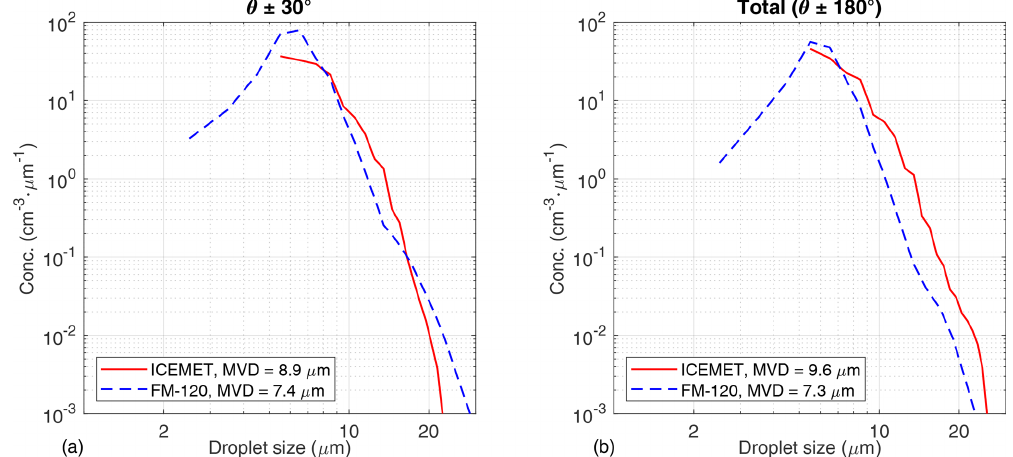
Figure 7. Intercomparison between ICEMET (red line) and FM-120 (dashed blue line) median DSDs for (a) isoaxial sampling with angular deviation ( θ ± 30 ◦ ) and (b) the total data set including all wind directions ( θ ± 180 ◦ ).